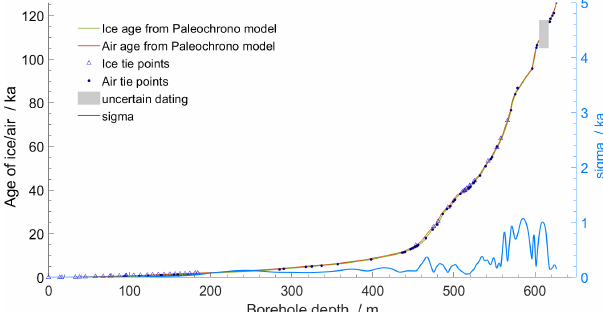
Figure 11. Age against depth for the Skytrain Ice Rise ice core. In the top panel, ice and air age are shown, along with the tie points we applied. The turquoise line shows the uncertainty on the ice age derived from Paleochrono, using the right hand y axis. The section with unreliable ages (605–617m) is greyed out, and the uncertain- ties around this section are probably